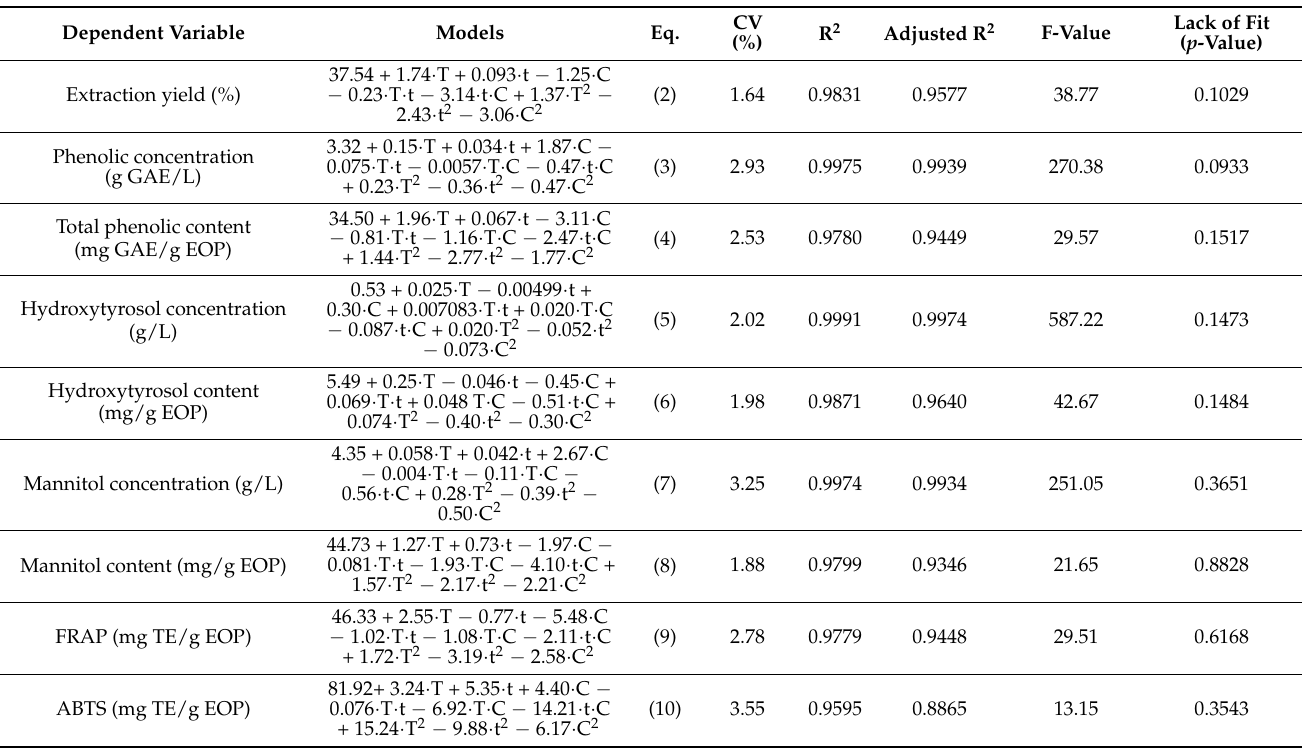
Table 2. Mathematical models (coded values) obtained in the Box-Behnken design for each response variable and statistical